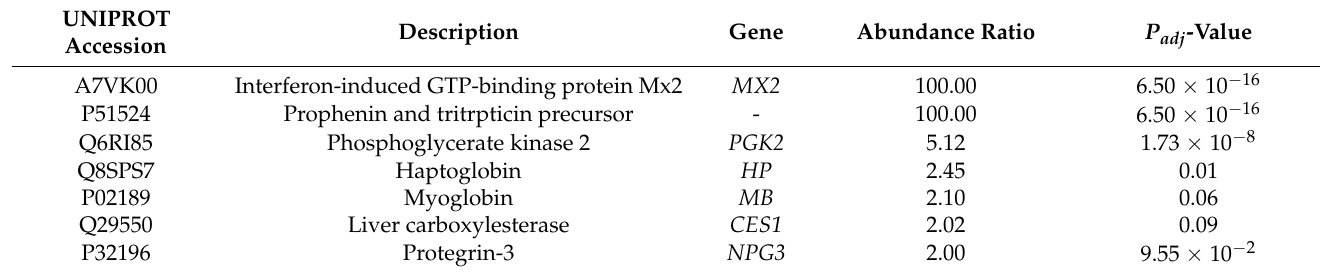
Table 3. Differentially expressed proteins* from muscle tissue, protein-coding genes, and their abundance ratio (SOY/LIN).